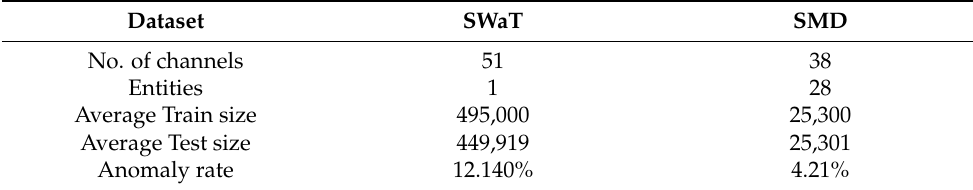
Table 1. Summary of the